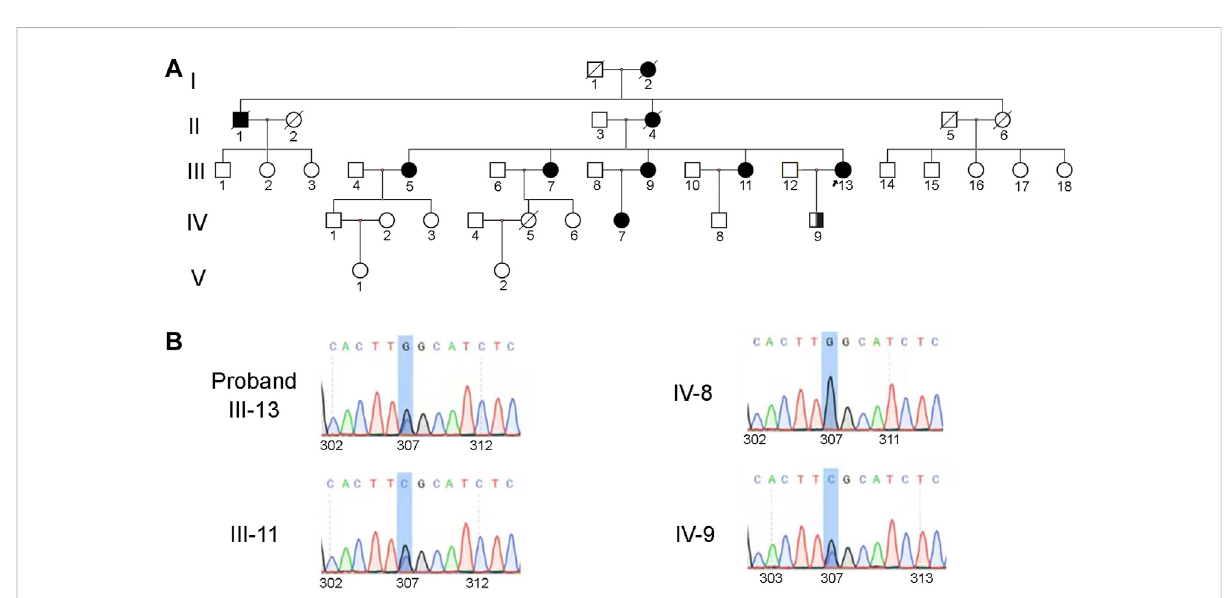
FIGURE 3 Heterozygous mutation (c.307G > C, p. G103R) in the TTR gene was identi fi ed in the family. (A) Pedigree of the family. Square symbols denote males, circle symbols denote females, solid symbols indicate the affected, open symbols indicate the unaffected, slash symbols indicate the deceased,symbolenclosingaverticalbarindicatetheasymptomaticcarrier,andanarrowbelowthesymbolindicatestheproband. (B) Theresultsof family separation andanalysisshowed thattheproband (IV-13),her daughter (IV-9), andher fourthsister (III-11) carriedheterozygosity. The son of her fourth sister (IV-8) carried the wild-type